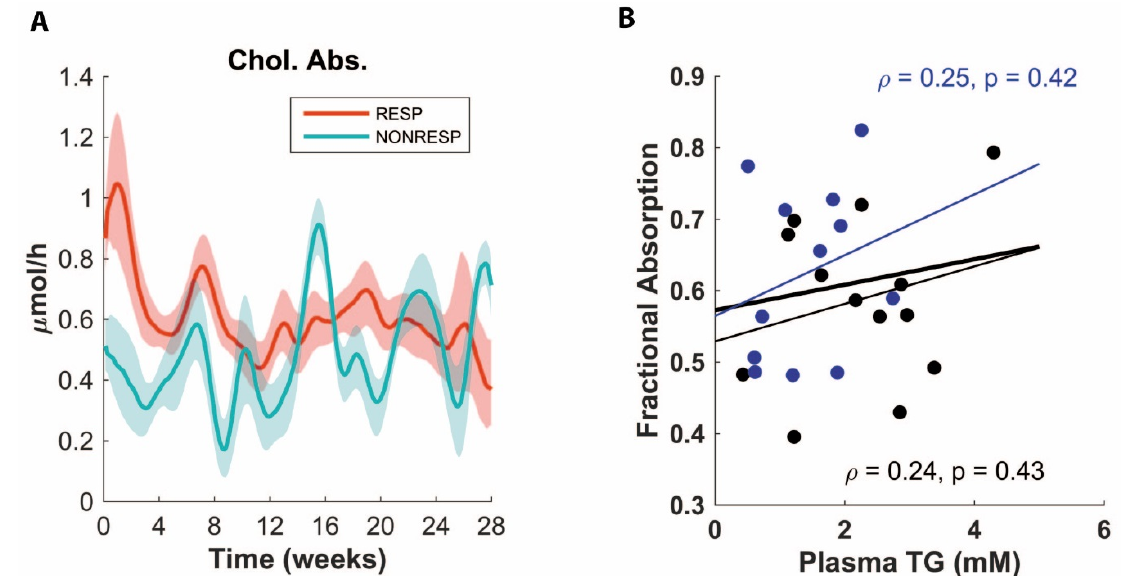
Figure 3. Cholesterol absorption (Chol. Abs.) as predicted by ADAPT ( A ) for responders (RESP) and non ‐ responders (NONRESP); note that ADAPT predicts lower level of cholesterol absorption for non ‐ responders. Fractional cholesterol absorption ( B ) in two cohorts (black and blue) of mice after 8 weeks of HFCD. Note there is no correlation between fractional cholesterol absorption and plasma TG.